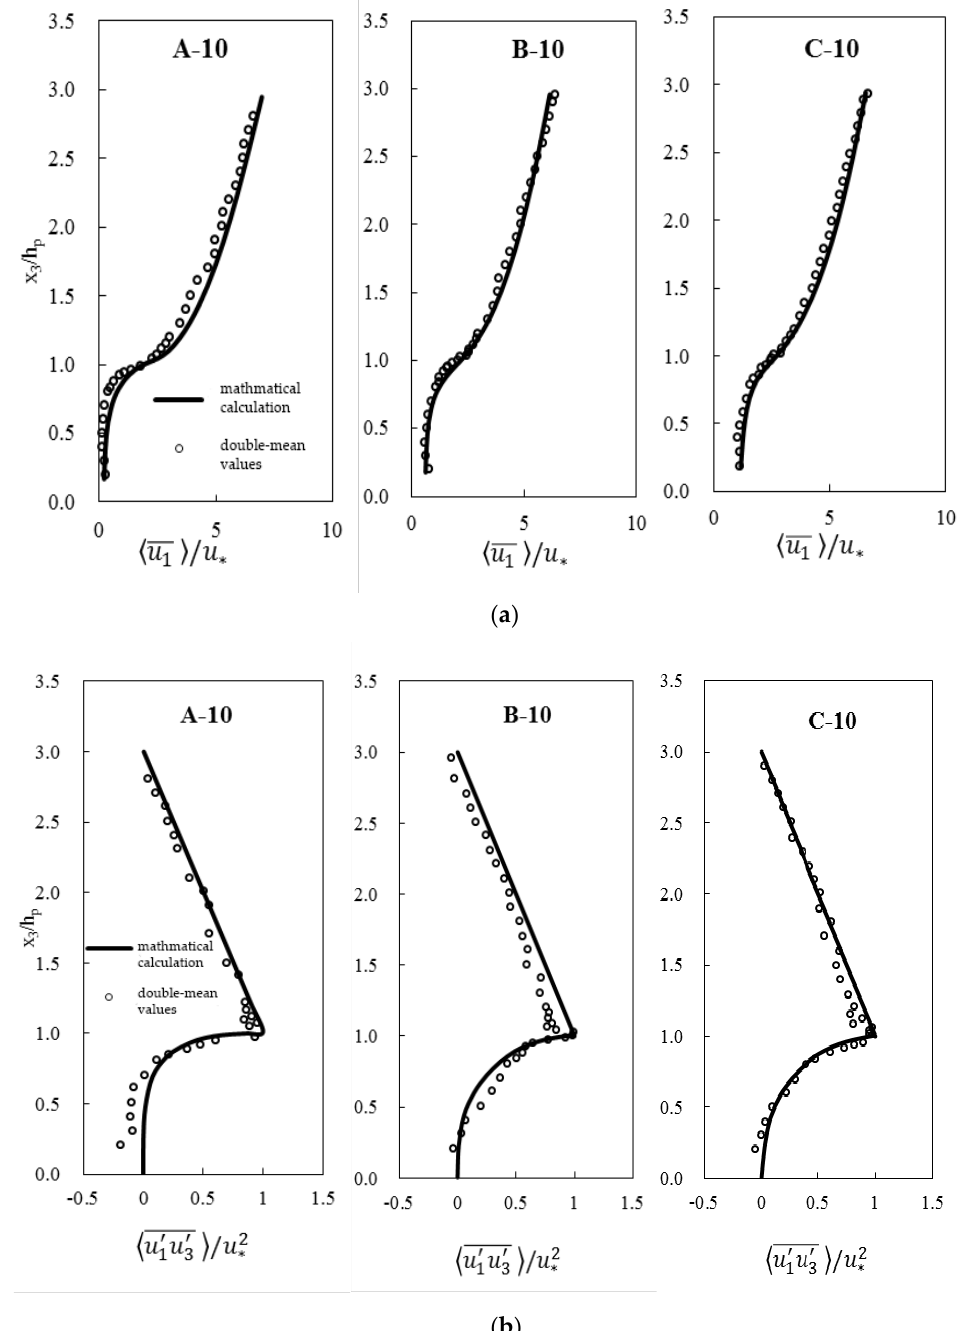
Figure 2. Verification calculation results of the double-mean longitudinal velocity and Reynolds stress (experimental data source: Nezu et al. [4]): ( a ) verification calculation results of the double mean longitudinal velocity; ( b ) verification calculation results of the double-mean Reynolds stress.